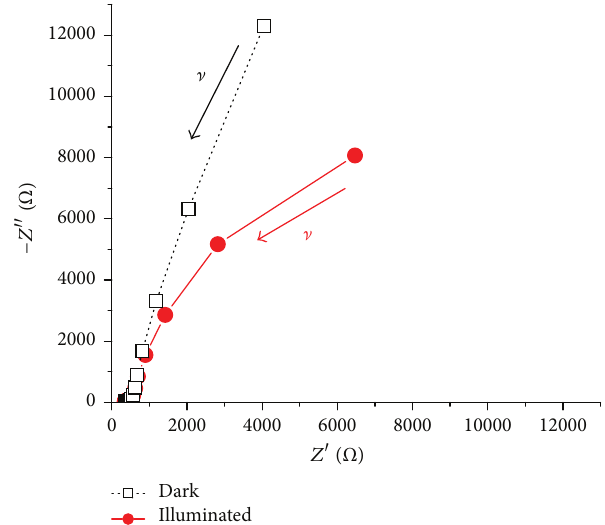
Figure 28: Electrochemical impedance spectra of ERY-sensitized RDS NiO in dark conditions and irradiated with white light (source: = 28.6 Wcm −2 ). Spectra have been displayed halogen lamp with 𝐼 in as Nyquist plots. NiO film thickness: 0.3 𝜇 m; substrate: ITO. ERY- sensitized RDS NiO sample was polarized at 3.0 V versus Li + /Li during the recording of both spectra. Arrows indicate the direction of increase for the frequency of polarization.